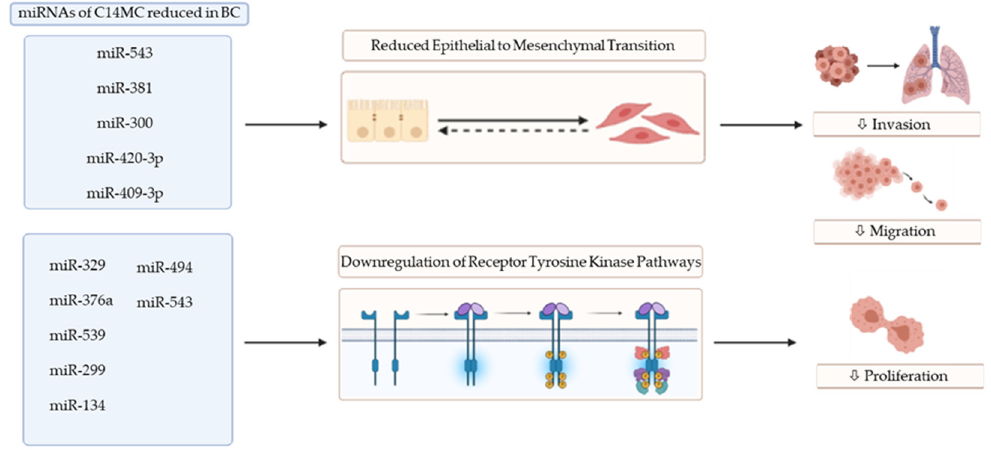
Figure 1. Functional impact of miRNAs of C14MC on epithelial to mesenchymal transition and receptor tyrosine kinase pathways. Abbreviations: BC: breast cancer; ⇩ : decreased (image created us- ing Biorender.com—paid subscription. Accessed on 9 July 2021 Biorender 2021).